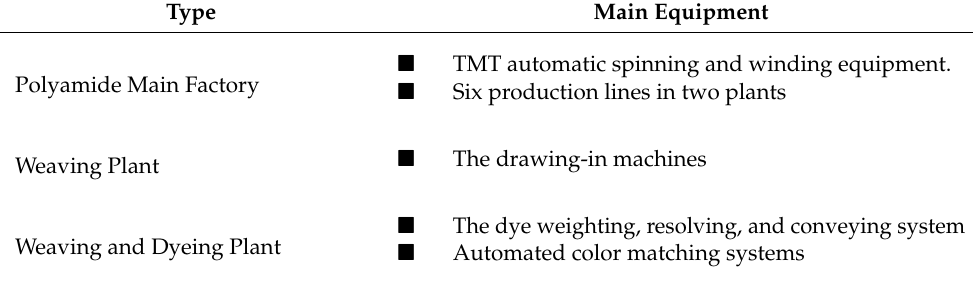
Table 2. Production facilities of the use case.